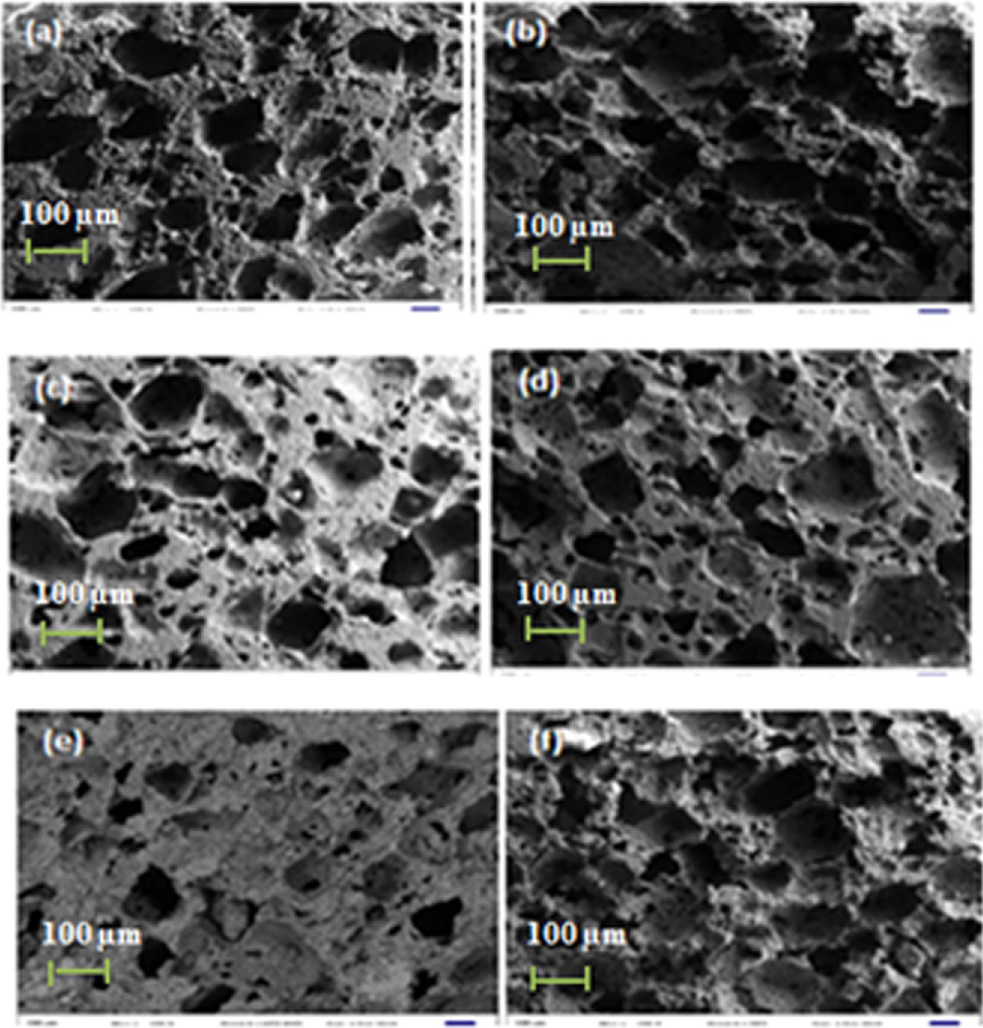
Figure 8. SEM micrographs of porous S53B50, P40B10 and Sr bioactive scaffolds mixed with ( a ), ( c ) and ( e ) 60 vol.% (NH